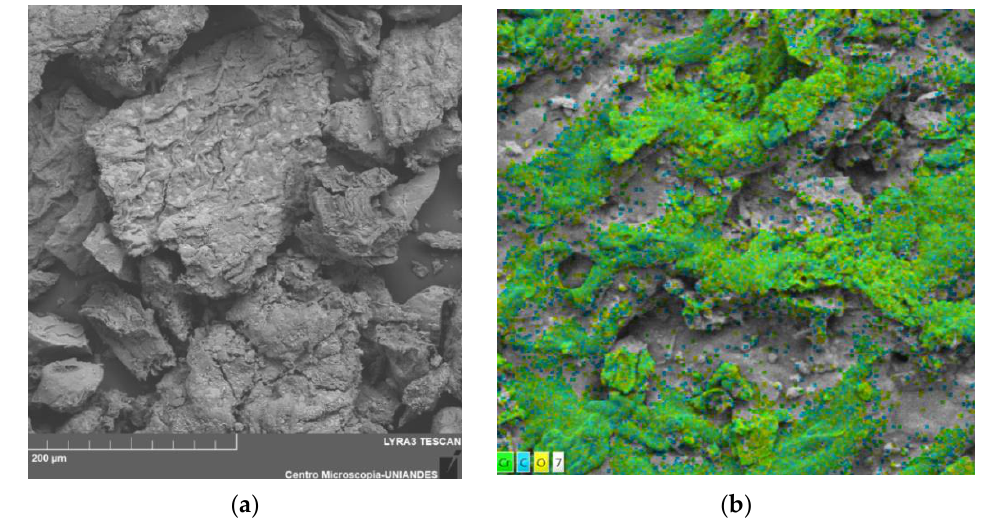
Figure 2. Biomass before ( a ) Cr (VI) adsorption; biomass of EC with Cr (VI) in ( b ).